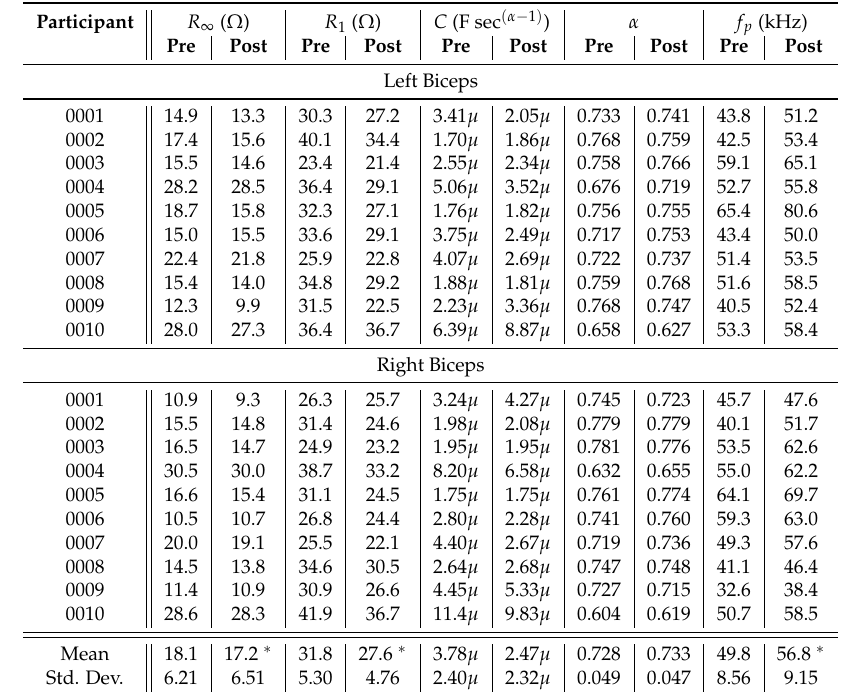
Table 1. Extracted equivalent circuit parameters from pre- and post-fatigue impedance measured from the left and right biceps of participants in the 60% one-repetition maximum (1-RM)